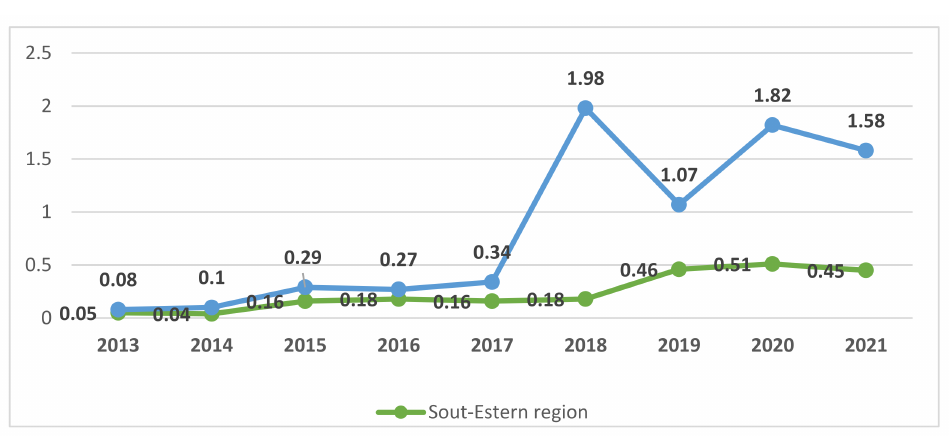
Figure 5. Productivity index for attracting foreign direct investment in electricity, gas, steam, and air conditioning in the south-eastern region of Ukraine, 2013–2021 (constructed by the authors according to the data